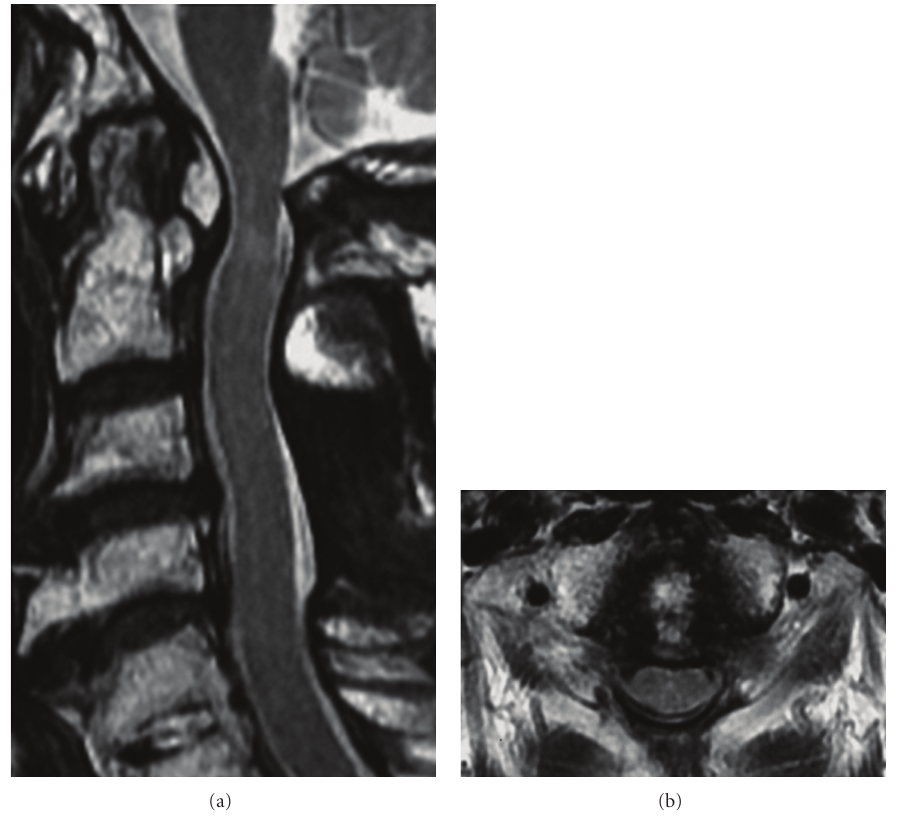
Figure 5: Postoperative MRI on T2-weighted image. Sagittal (a) and axial (b) plane. The spinal cord had been decompressed.